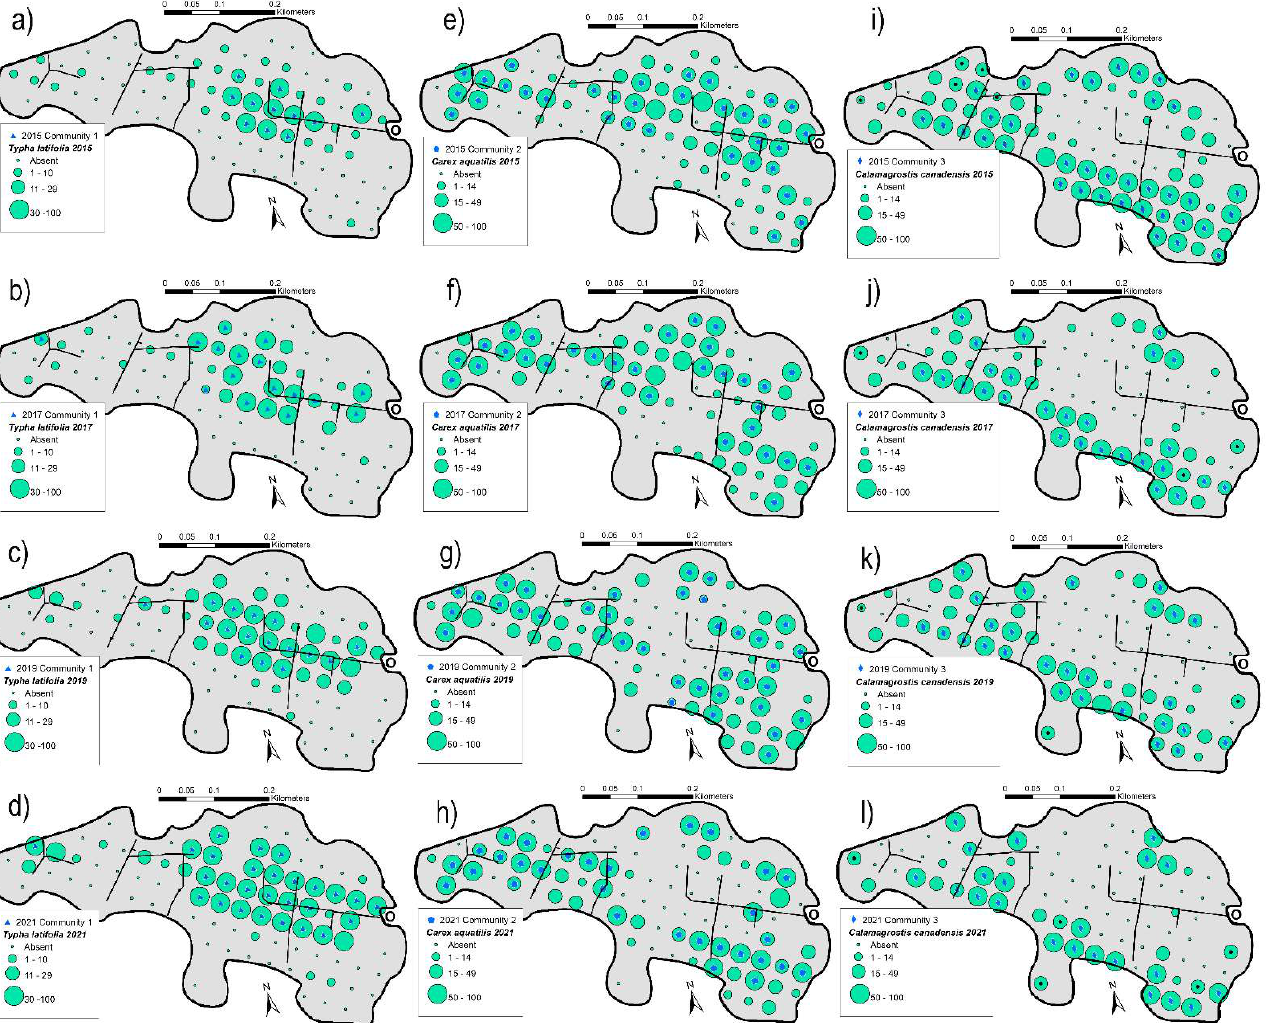
Figure 2. Spatial distribution of three plant communities (1–3) on Sandhill Wetland for ( a , e , i ) 2015, ( b , f , j ) 2017, ( c , g , k ) 2019, and ( d , h , l ) 2021, with abundance of dominant species in each. Distribution of Plant Community 1 (blue triangles) with abundance (as % cover) of Typha latifolia overlain ( a – d ). Distribution of plant Community 2 (blue circles) with an abundance of Carex aquatilis overlain ( e – h ). Distribution of Plant Community 3 (blue diamonds) with an abundance of Calamagrostis canadensis overlain ( i – l ). Black circles indicate outlier plots (Group 4). O = Outlet of Sandhill Wetland.